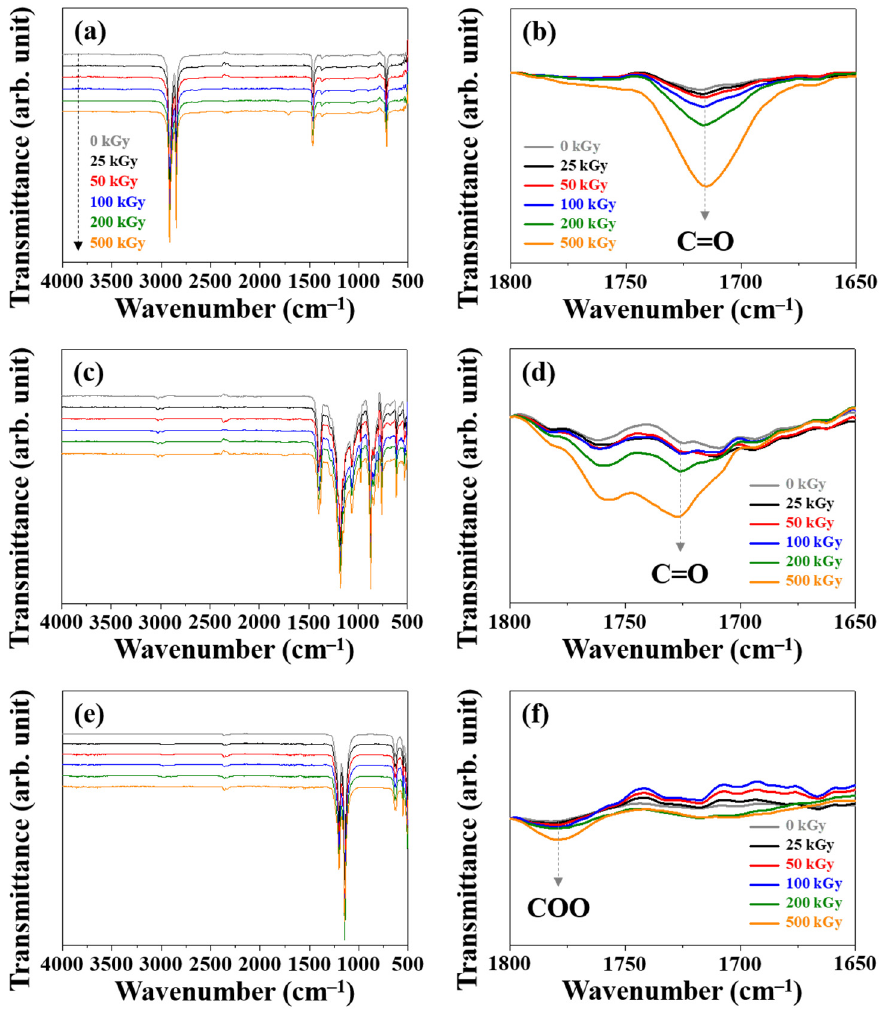
Figure 1. FTIR spectra of ( a , b ) PE, ( c , d ) PVDF, and ( e , f ) PTFE .